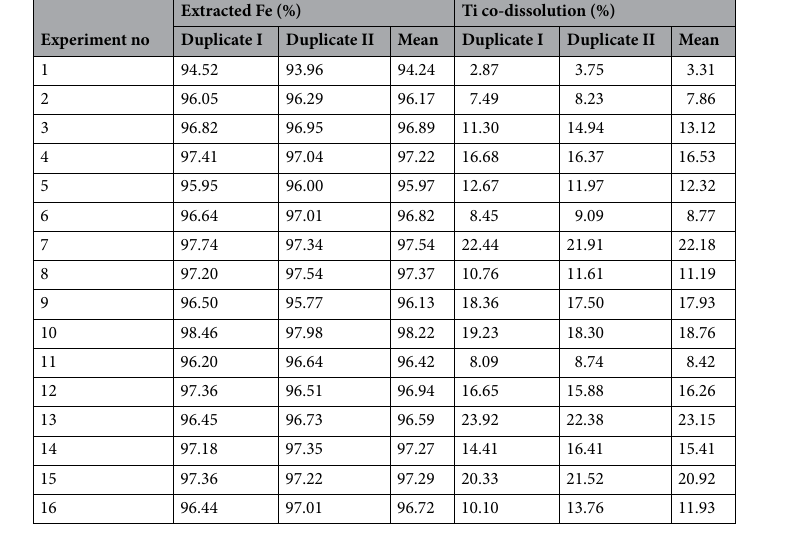
Table 5. Results of leaching experiment of pre-oxidized